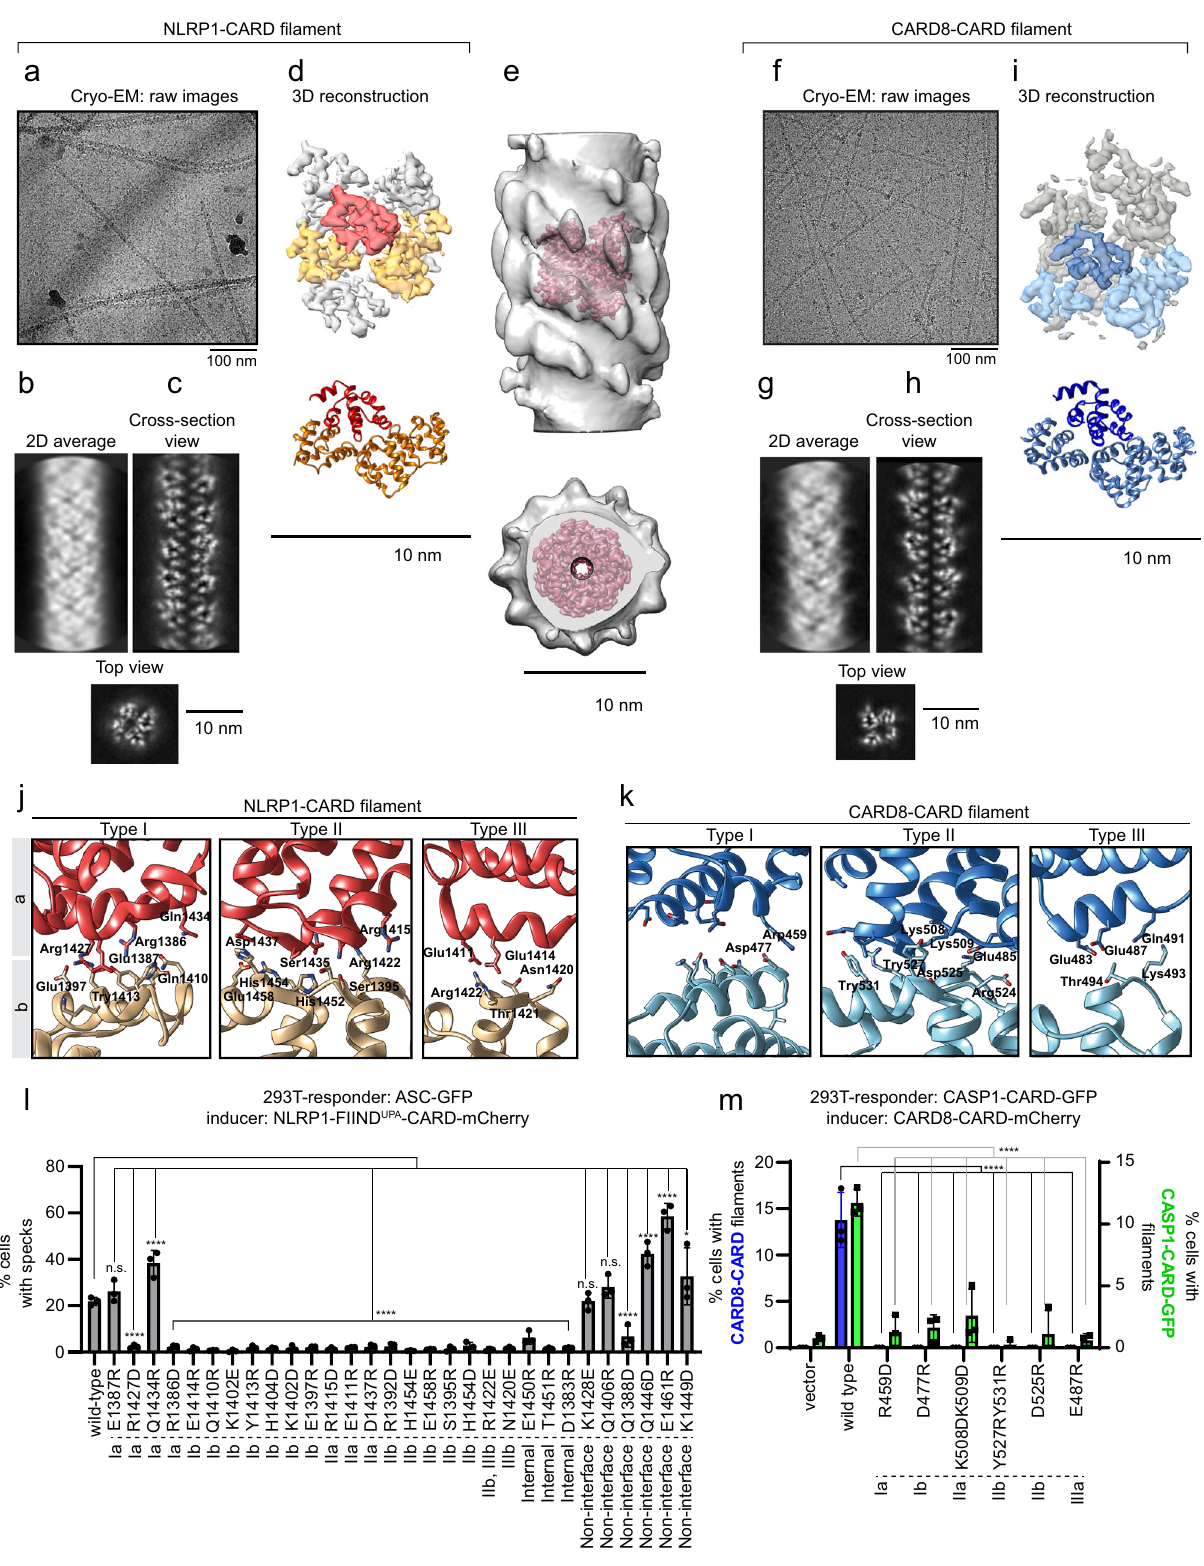
GFP or CASP1-CARD-GFP specks/ fi laments (Fig. 2l, m), whereas non-interface surface-exposed residues have less effect. These results further prove that CARD oligomerization is a prerequisite for NLRP1 and CARD8-driven in fl ammasome activation. A notable exception is the type Ia interface of NLRP1, where two of the four mutations, E1387R and Q1434R, did not affect